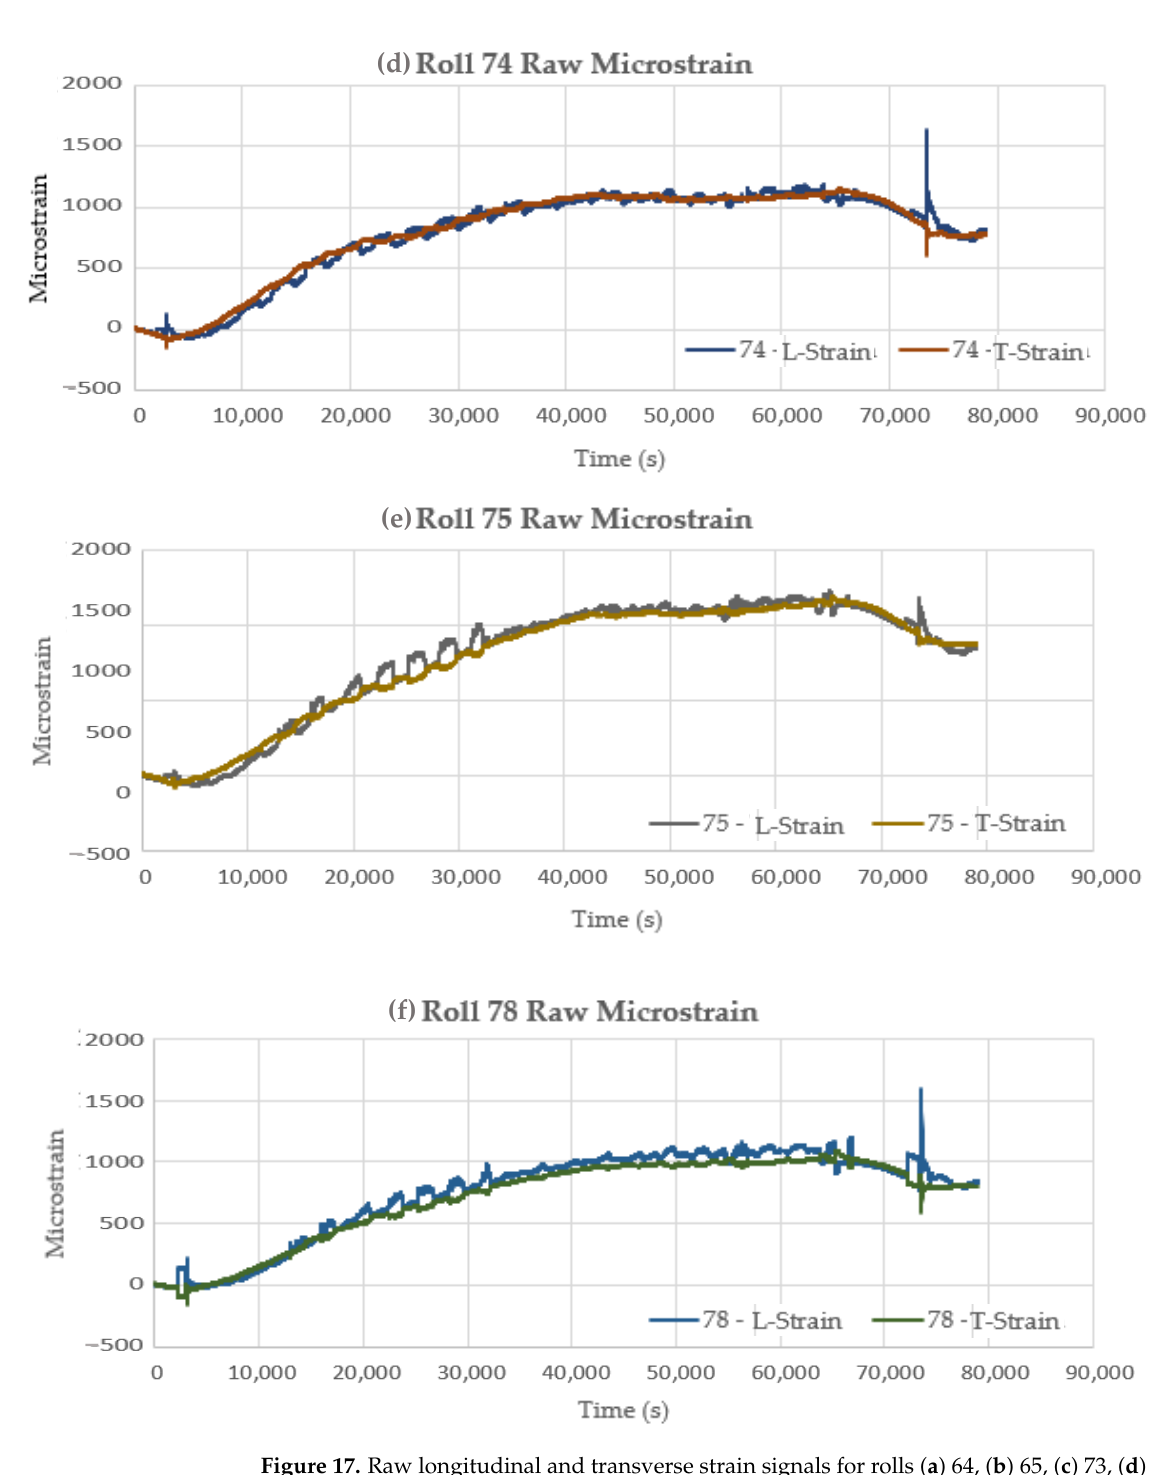
Figure 17. Raw longitudinal and transverse strain signals for rolls ( a ) 64, ( b ) 65, ( c ) 73, ( d ) 74, ( e ) 75, and ( f ) 78.